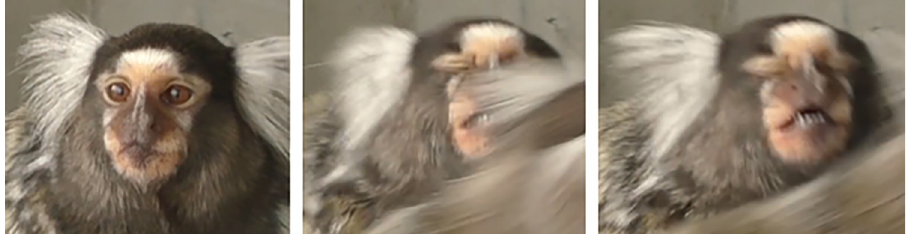
Fig 8. Left: Neutral; Centre: AU6—Cheek Raiser at its apex; Right: AU6—Cheek Raiser returning to neutral. Still frames from S8 Video.